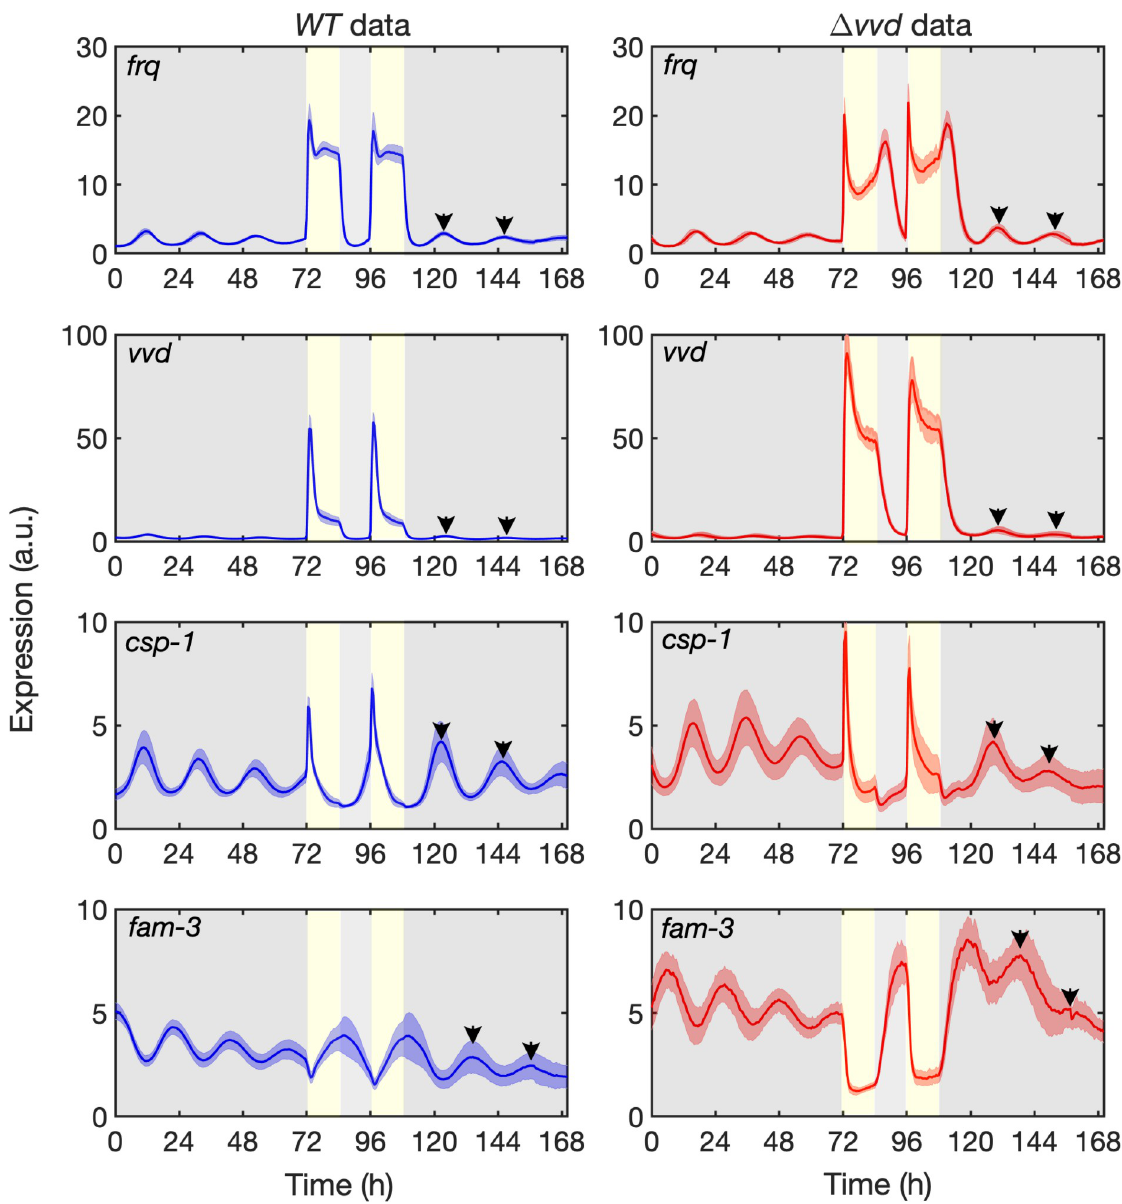
Fig 2. Temporal expression profiles of reporter genes in DD and LD. Luciferase activity under the control of the indicated promoters in WT (left panels) and Δ vvd (right panels). The solid line represents the average of 30 measurements from three independent experiments. The shaded areas correspond to the standard deviation, SD. Yellow vertical boxes and grey areas indicate 12h light periods and dark periods,